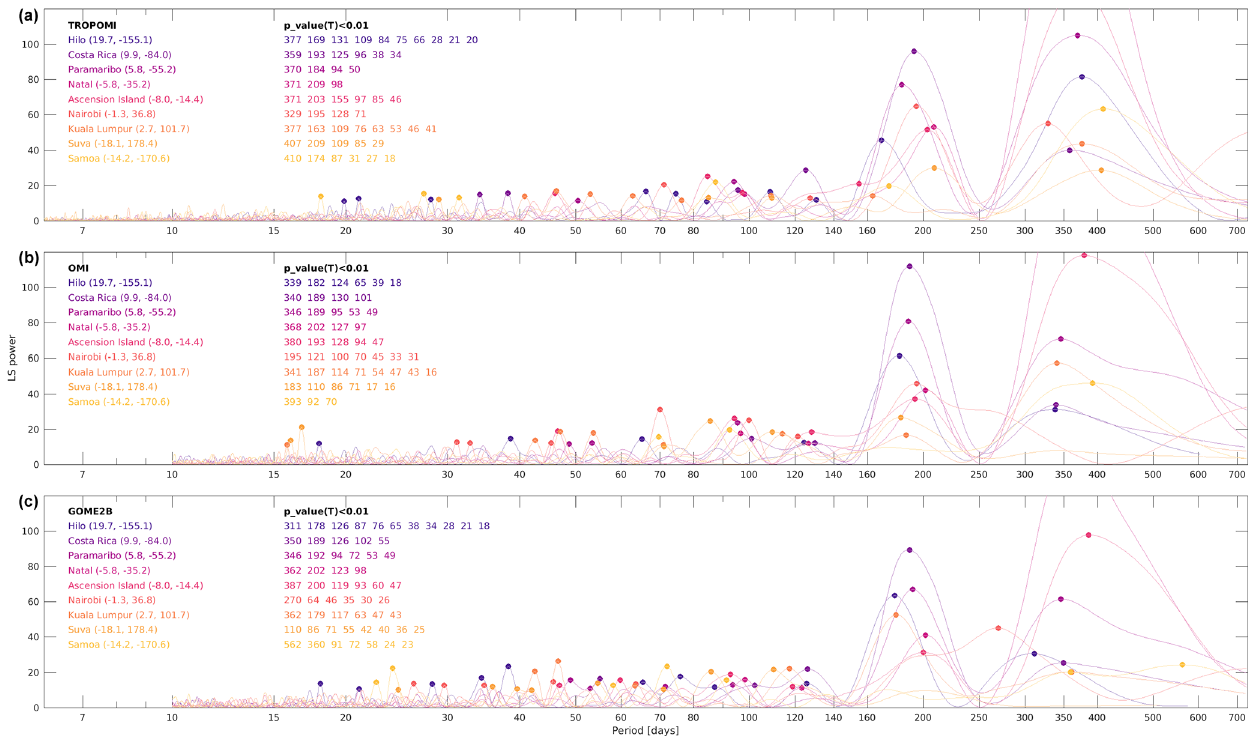
Figure 13. Lomb–Scargle periodogram for 2 years of tropospheric ozone columns over nine SHADOZ sites (coloured) for TROPOMI (a) , OMI (b) and GOME-2B (c) . Markers locate spectral peaks that cross the 1% significance threshold (red line). Annual and semi-annual cycles appear clearly over most of the